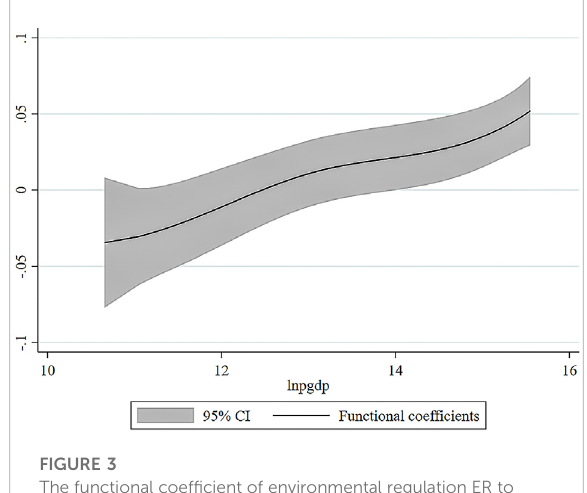
FIGURE 3 The functional coef fi cient of environmental regulation ER to agricultural green technology